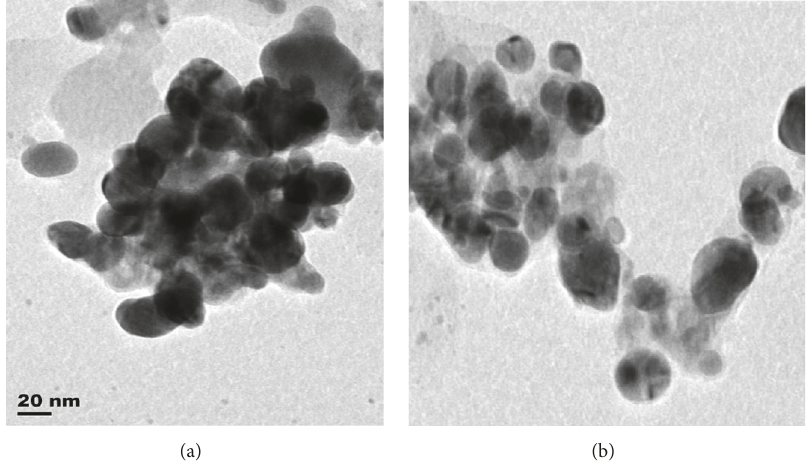
Figure 5: Representative TEM images of Ag/Ni bimetallic NPs derived from C. indicia leaf